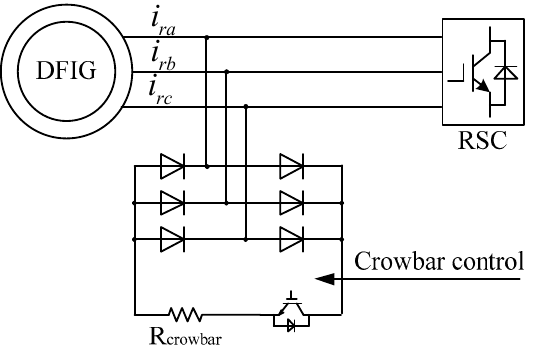
Figure 3. Crowbar circuit of DFIG system.